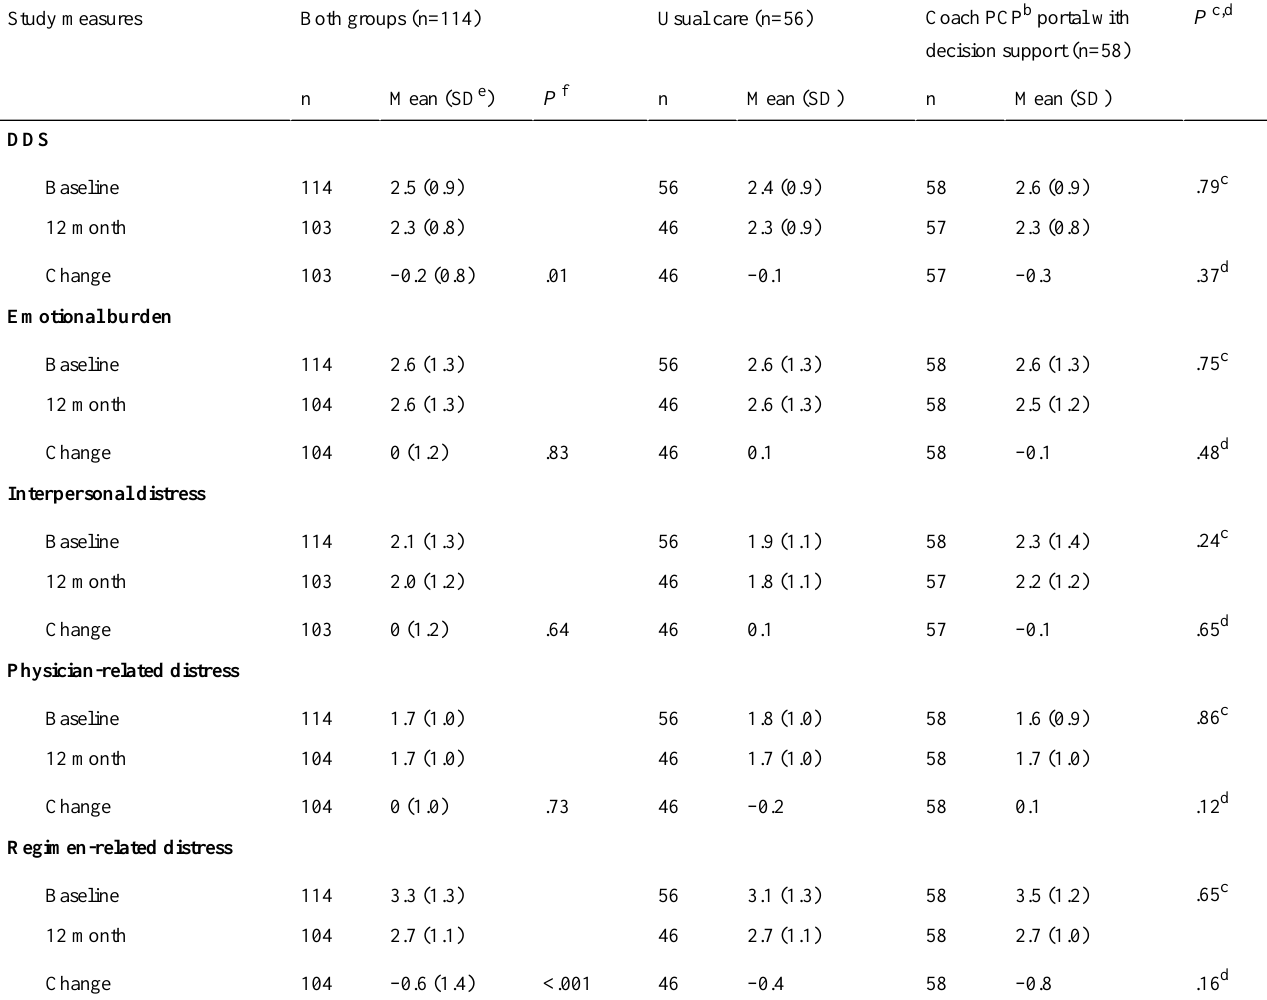
Table 2. Diabetes Distress Scale (DDS) a and subscale scores.